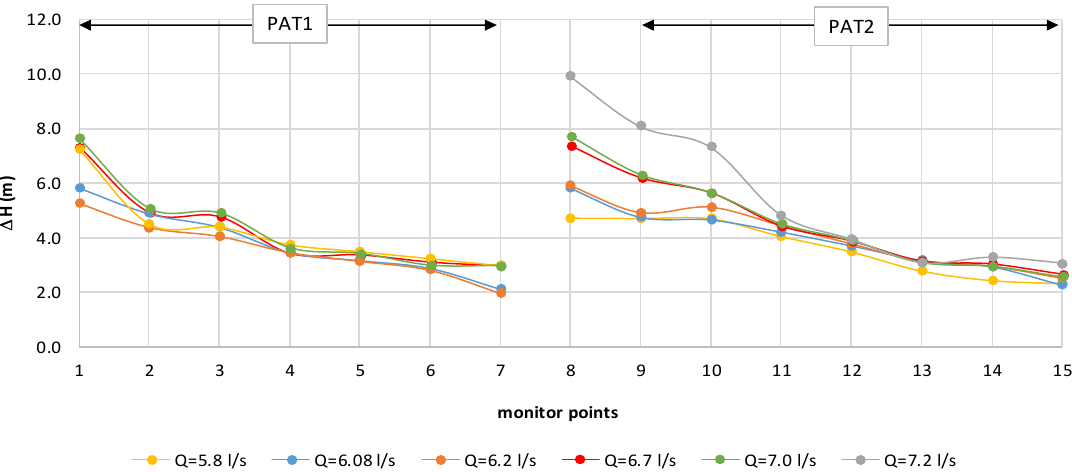
Figure 15. Head losses at monitor points along the PATs system for different total flow values.